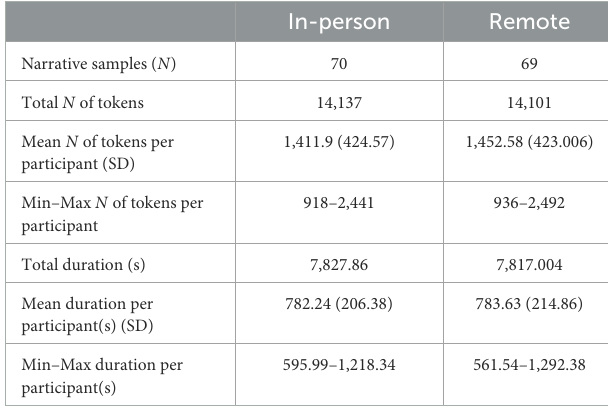
TABLE 3 Overview of the study dataset. In-person